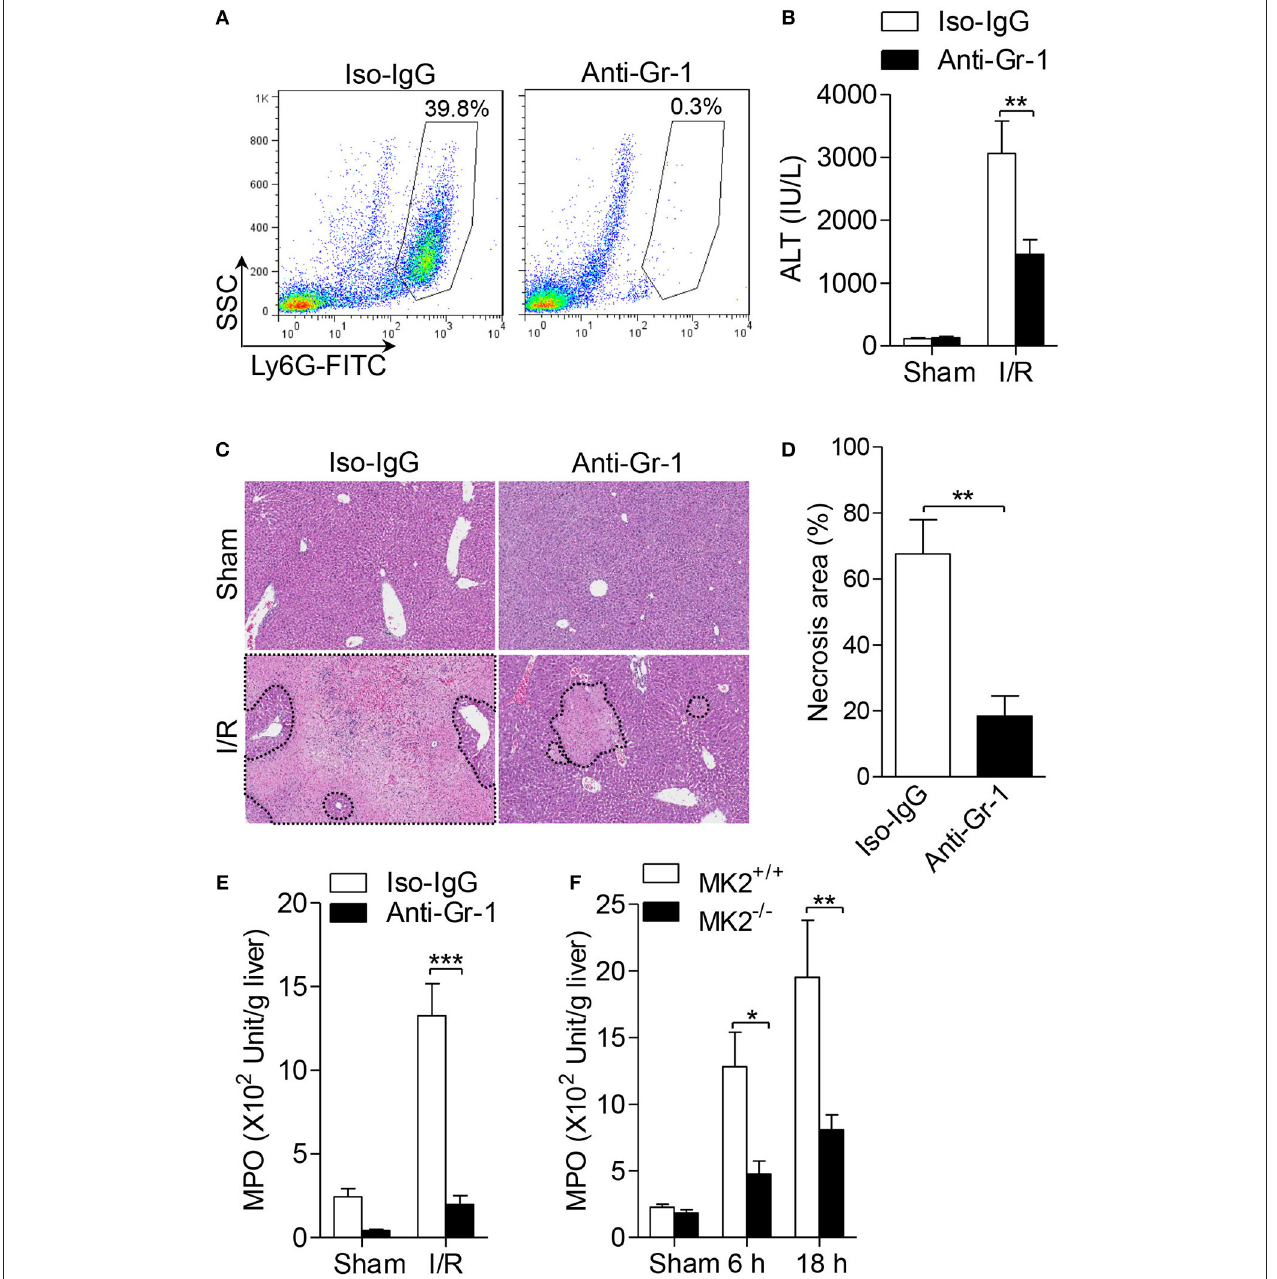
FIGURE 2 | Genetic MK2 deficiency reduced neutrophil trafficking in hepatic I/R injury. (A) The wild type mice (MK2 + / + ) were intraperitoneally injected with anti-Gr-1 antibody (1A8), or isotype-matched IgG as control for 24h, and then the percentage of neutrophils in peripheral blood were shown, as determined by anti-Ly6G-FITC FACS staining. (B) After injected with anti-Gr-1 antibody as in (A) , mice were subjected to hepatic ischemia for 60min and reperfusion for 18h. Serum ALT was detected for evaluation of liver injury. (C) Representative histological staining (H&E) of ischemic liver tissue was displayed. Original magnification × 100. (D) The necrosis area was quantified by ImageJ software. (E) The activities of MPO activity of injury liver tissues were detected. (F) MK2 + / + and MK2 − / − mice were subjected to hepatic I/R injury as in Figure 1 , the activities of MPO in liver tissue extract were evaluated. The results are shown as means ± SEM. * P < 0.05; ** P < 0.01, *** P < 0.001, based on 5 mice in each group.